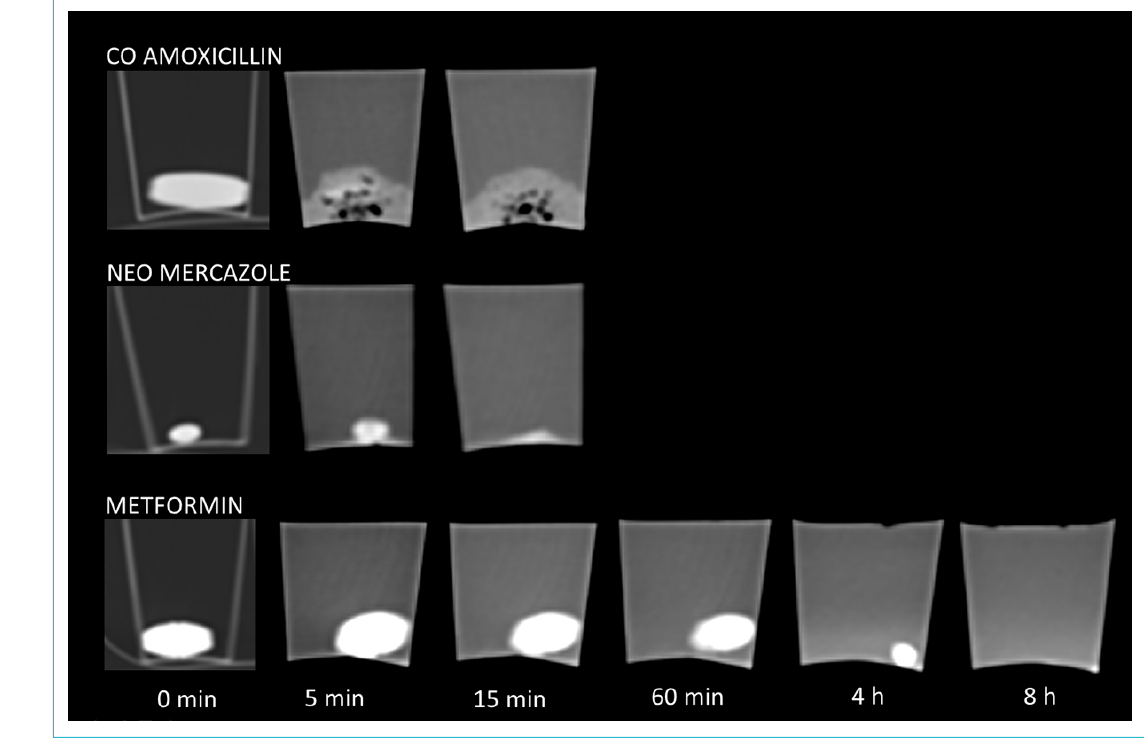
Figure 5: Dissolution process of medicaments in hydrochloric acid (pH 2): Co-Amoxicillin was already dissolved after 5 min (note the small black air bubbles during the decay). Neo Mecazole was still intact after 5 min and dissolved after 15 min. Metformin demonstrated the same shape and density over 60 min and was dissolving after 4 hours. Note the hyperdense liquid in the cup at 8